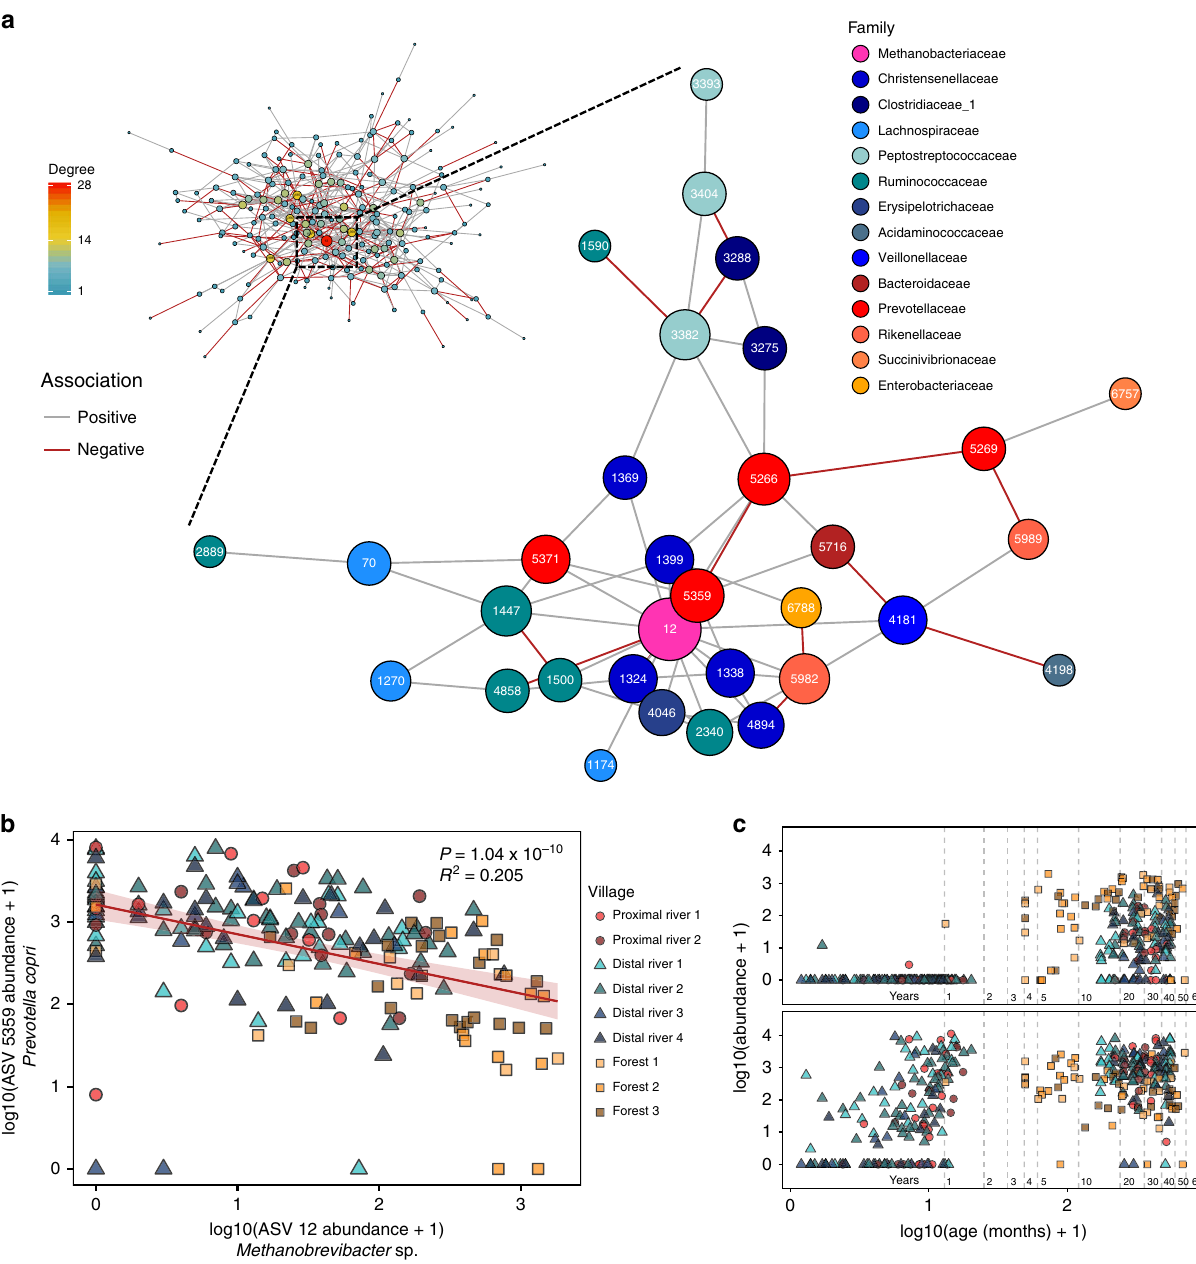
Fig. 6 Network analysis reveals an inverse relationship between highly connected taxa. a A network diagram of ASVs observed at least ten times in at least 20% of Tsimane adult stool samples. The size of the node was scaled to represent its degree of connectedness. The insert shows the complete network colored by network degree, while the main fi gure shows the highly connected subgraph colored by each ASV ’ s taxonomic family. Positive associations between ASV nodes are colored gray, while negative associations are colored red. b A scatter plot of the log 10 transformed relative abundances of the two most highly connected ASVs in the network, Methanobrevibacter spp. (ASV 12) and Prevotella copri (ASV 5359) ( P = 1.04 × 10 − 10 , R 2 = 0.205). The red line indicates the linear mixed-effects regression while treating subject as a random effect, and shading indicates the 95% con fi dence interval. The marginal R 2 describes the proportion of variation explained by the fi xed factors alone, and was calculated using the R package, “ piecewiseSEM ” . Samples are colored by village, and their shapes represent the village type (proximal river — circles, distal river — triangles, forest — squares). c Scatter plot of the relative abundances of Methanobrevibacter spp. (ASV 12) and Prevotella copri (ASV 5359) and the subject ’ s age in months at the time of collection. The x-axis was log 10 transformed for clarity when plotting both infant and adult samples. Ages 1 – 5, 10, 20, 30, 40, 50, and 60 years are denoted by horizontal dashed lines. Source data are provided in the Source Data fi